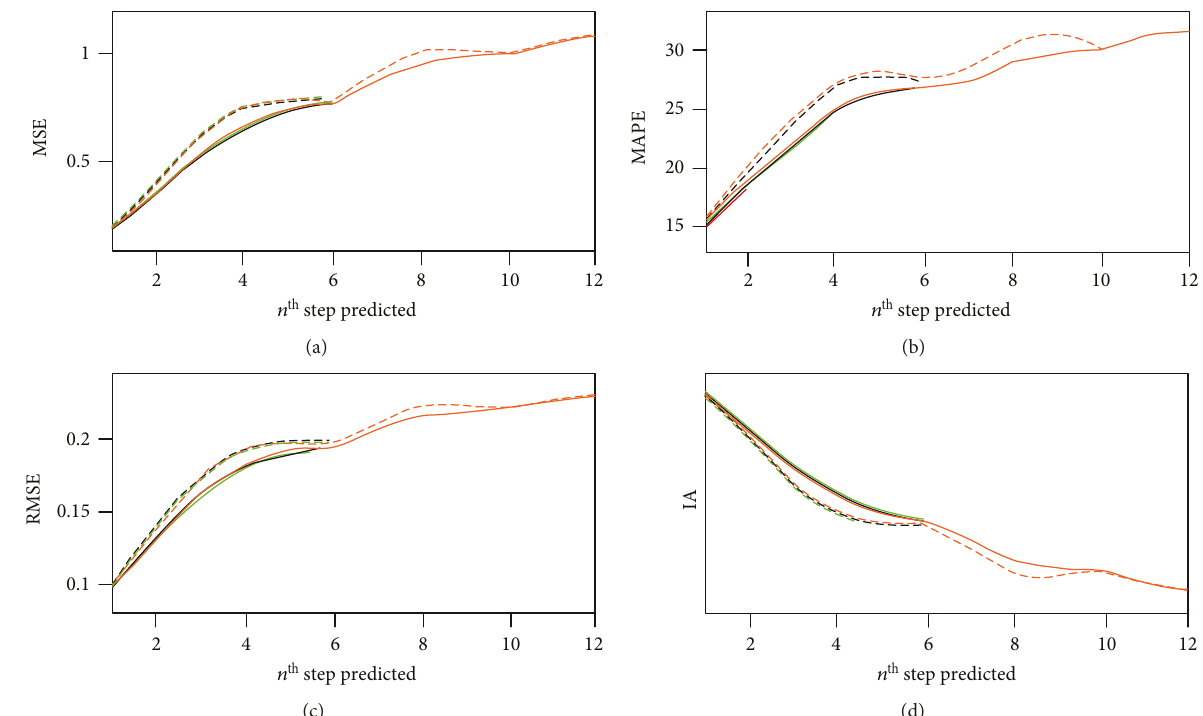
Figure 9: Manufacturing system: indicators from ANN (solid) and from LS-SVM (dashed) — (a) MSE, (b) MAPE, (c) RMSE, and (d) IA.